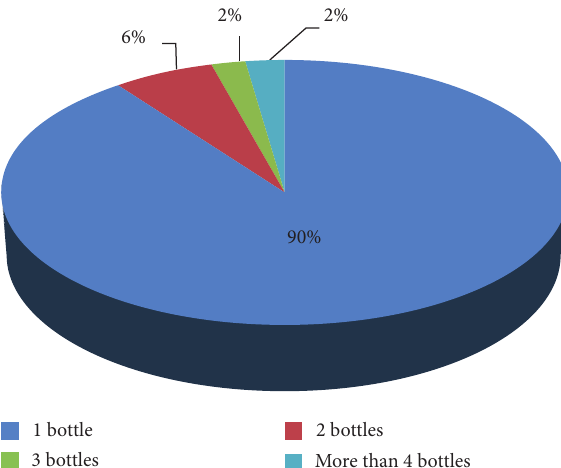
Figure 5: Number of bottles consumed per one purchase (fruit nectar).